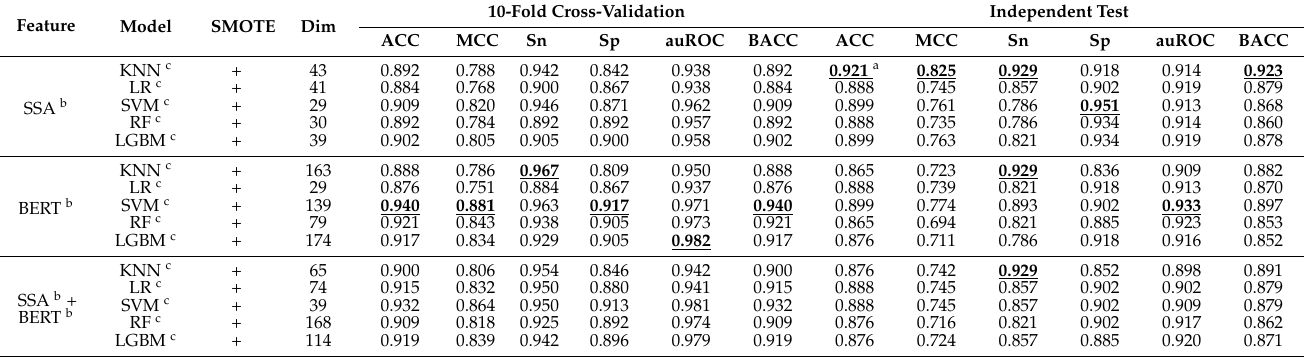
Figure 3. The performance metrics of individual and fused features with SMOTE, according to the machine learning methods used. ( A ) Ten-fold cross-validation results. ( B ) Independent test results. Table 3. Performance metrics of individual and fused features according to the machine learn- ing